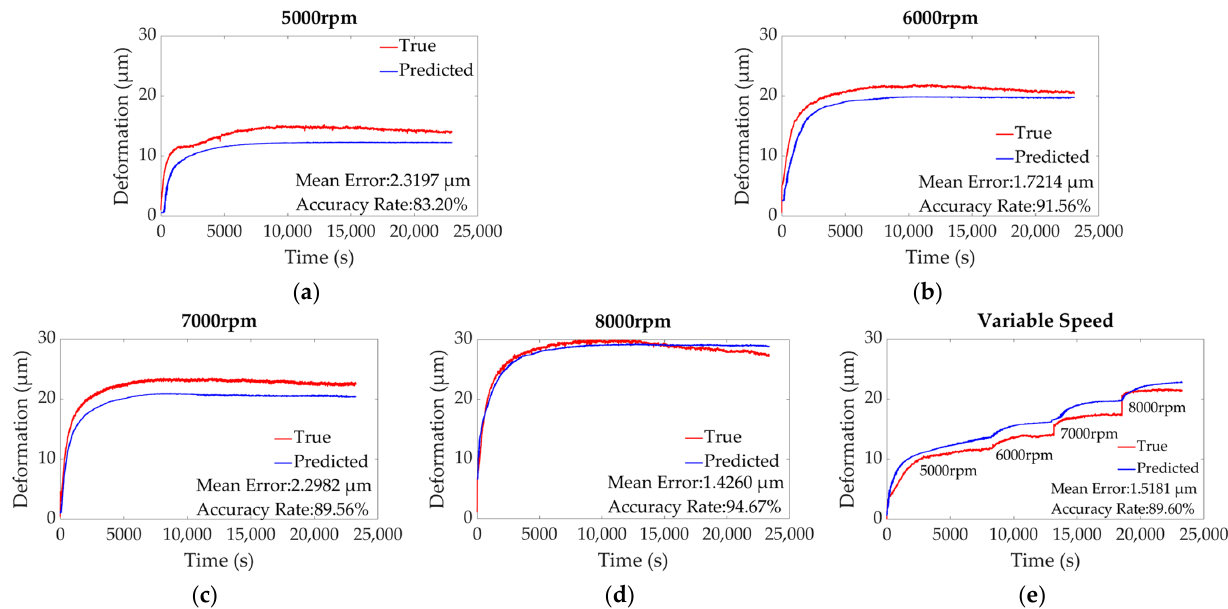
Figure 10. The external validation of the thermal error model trained by random forests under the rotational speed of ( a ) 5000 rpm; ( b ) 6000 rpm; ( c ) 7000 rpm; ( d ) 8000 rpm; ( e ) variable speed.